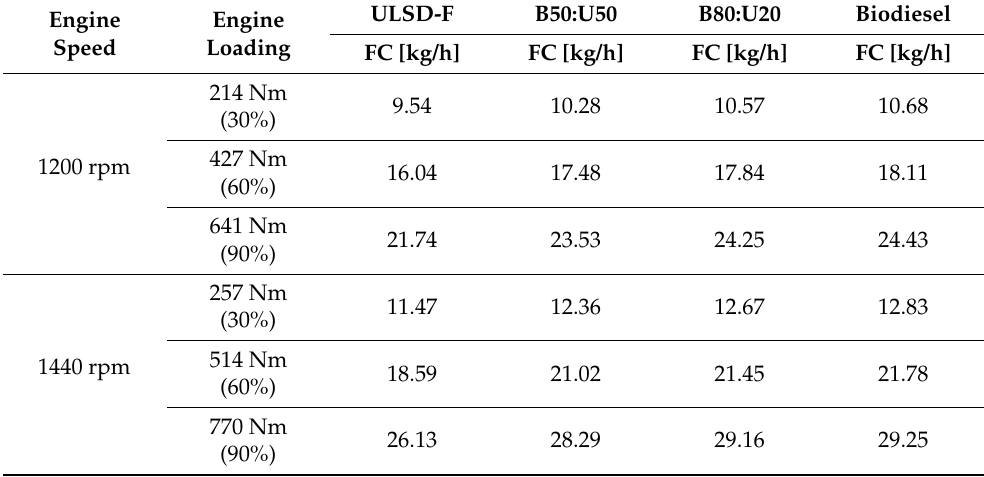
Table 4. Various test fuel mixtures’ fuel consumption at different engine loads and engine